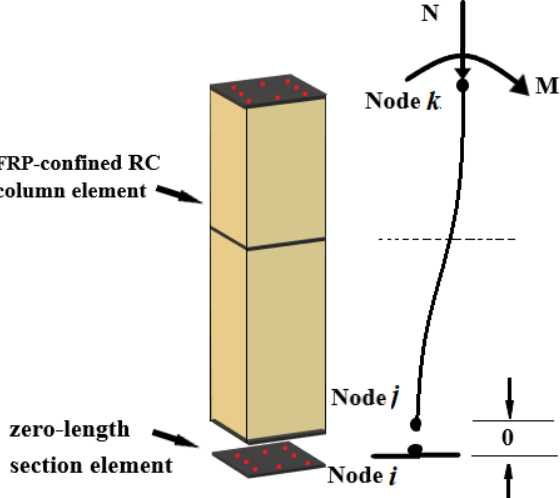
Figure 1. Fiber-based modeling of strain penetration effects.